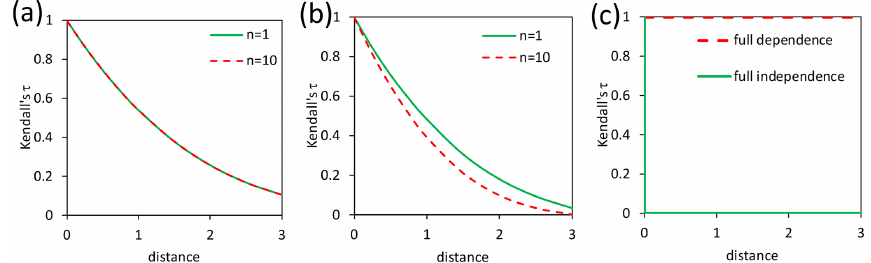
Figure 2. Spatial dependence in relation to the distance measured by Kendall’s τ : (a) max-stable fields of Fig. 1, (b) non-max-stable fields of Fig. 1, and (c) limit